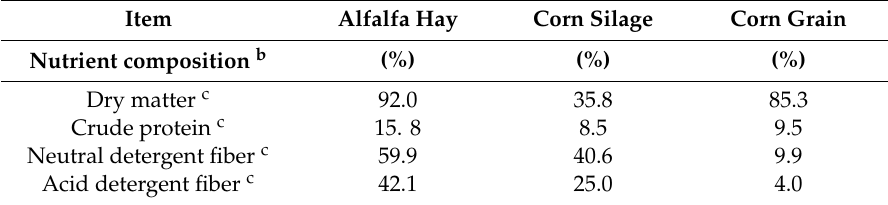
Table 1. Chemical composition of alfalfa hay, corn silage and corn grain samples which conformed the basal diet of yearling crossbred goats ( n = 22) under natural photoperiodic (April–May, 26 ◦ N) a